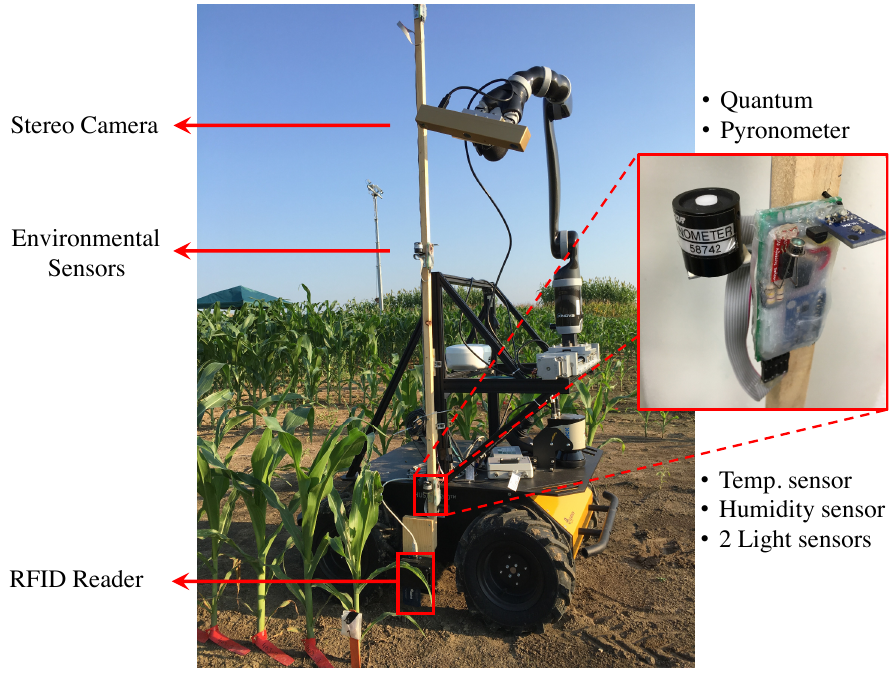
Figure 2. Hardware components of